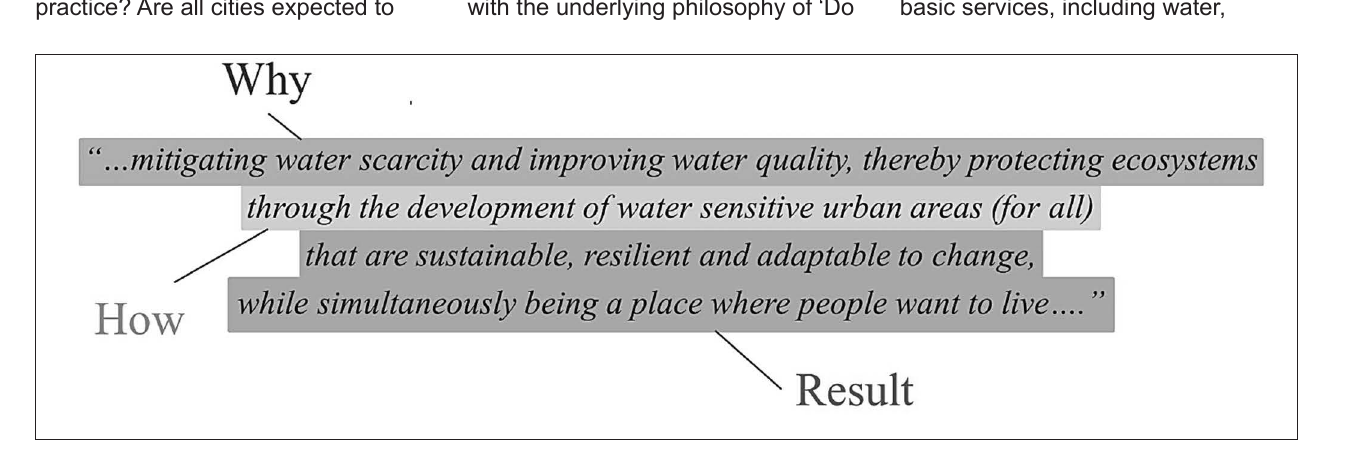
Figure 3: Suggested narrative for Water Sensitive Cities in South